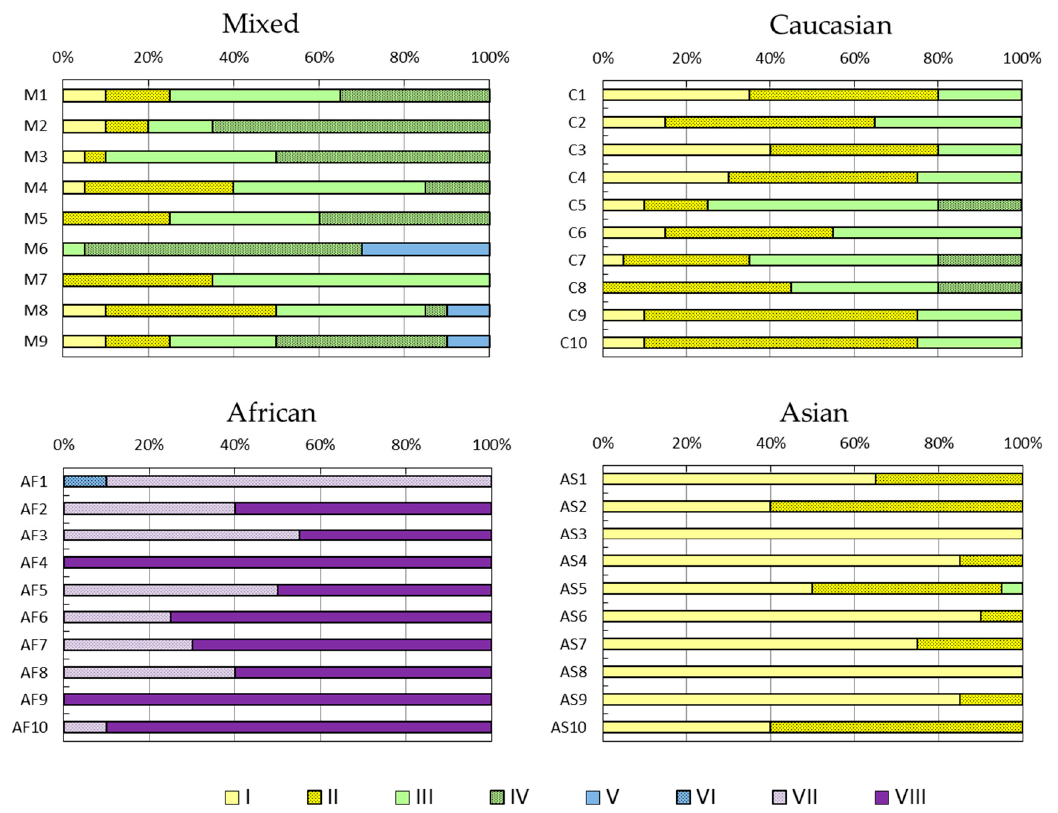
Figure 2. Classification of mixed, Caucasian, African and Asian hairs.